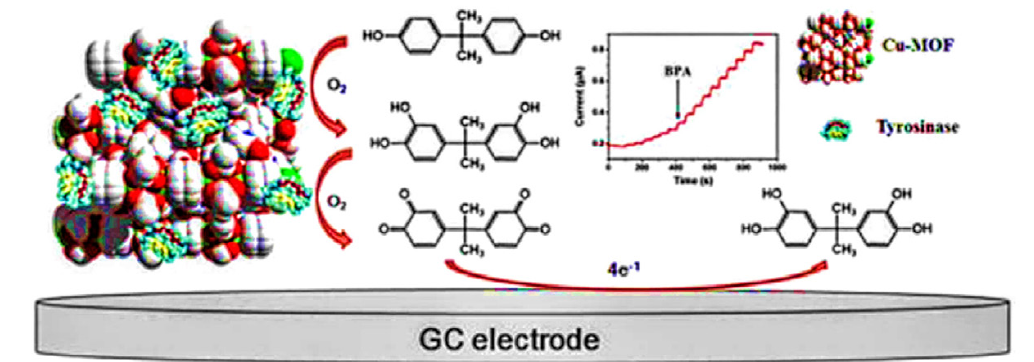
Fig. 2. 3D-MOFs as a biosensor for ultrasensitive and rapid detection of BPA. The large surface area of MOFs exhibited a favorable effect on the adsorption of both tyrosine enzyme and BPA which led to improving the sensor activity for ultrasensitive detection of 50 nM to 3 μM BPA. Reproduced with permission from reference [41]copyright (2015) ELSEVIER.